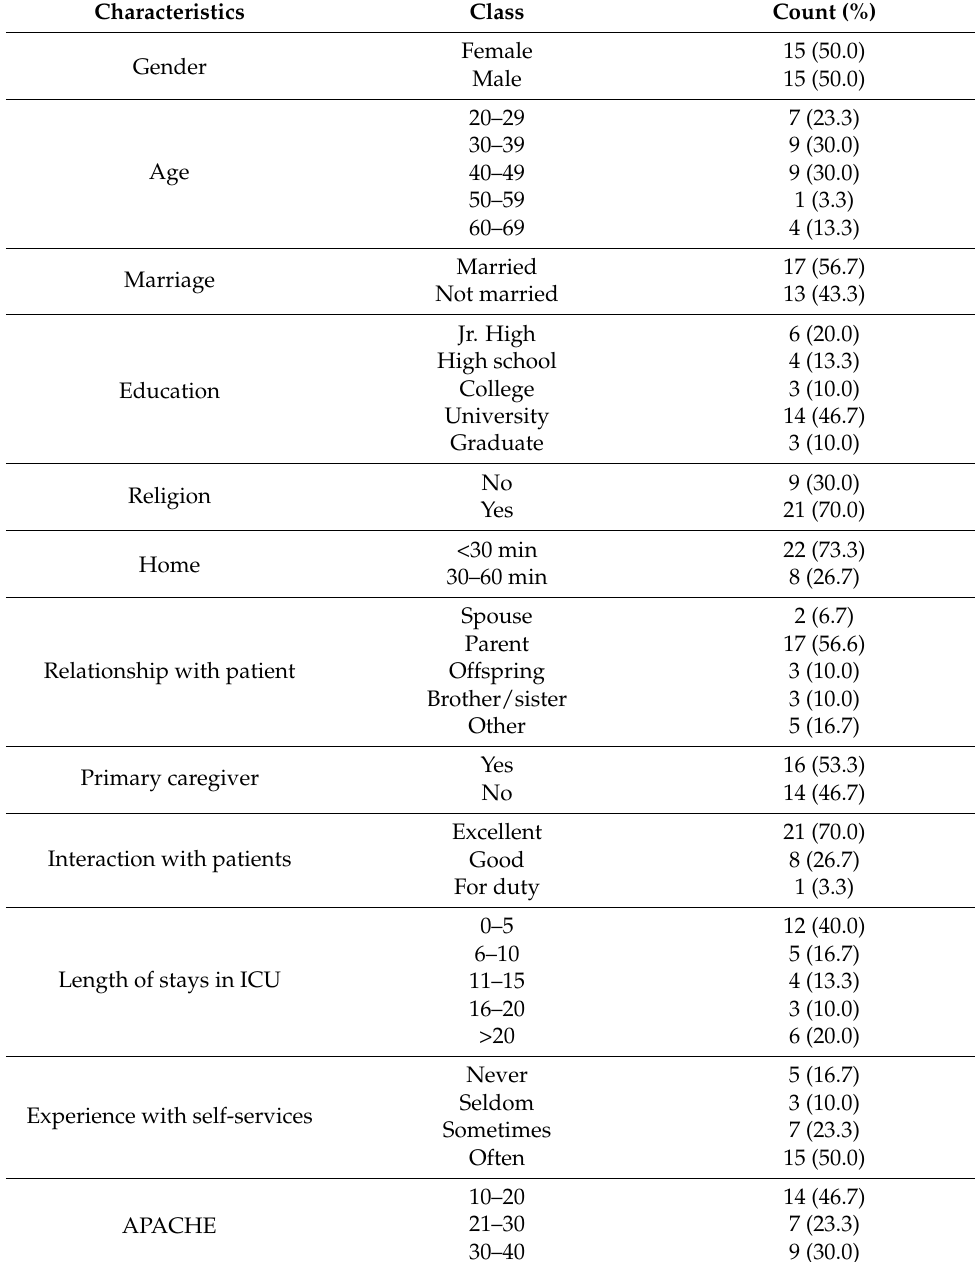
Table 2. Basic information on the